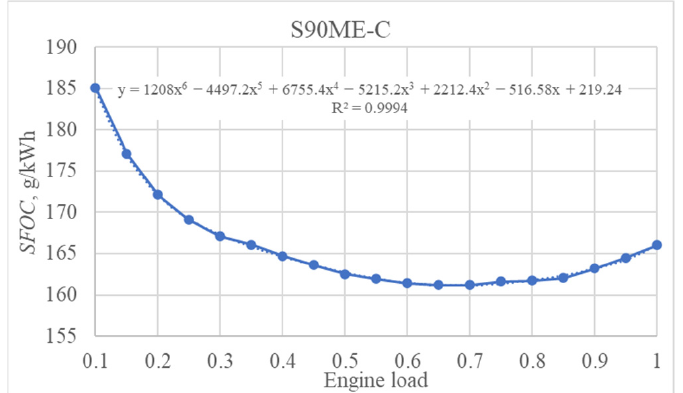
Figure 1. SFOC versus engine load for MAN B&W S90ME-C.